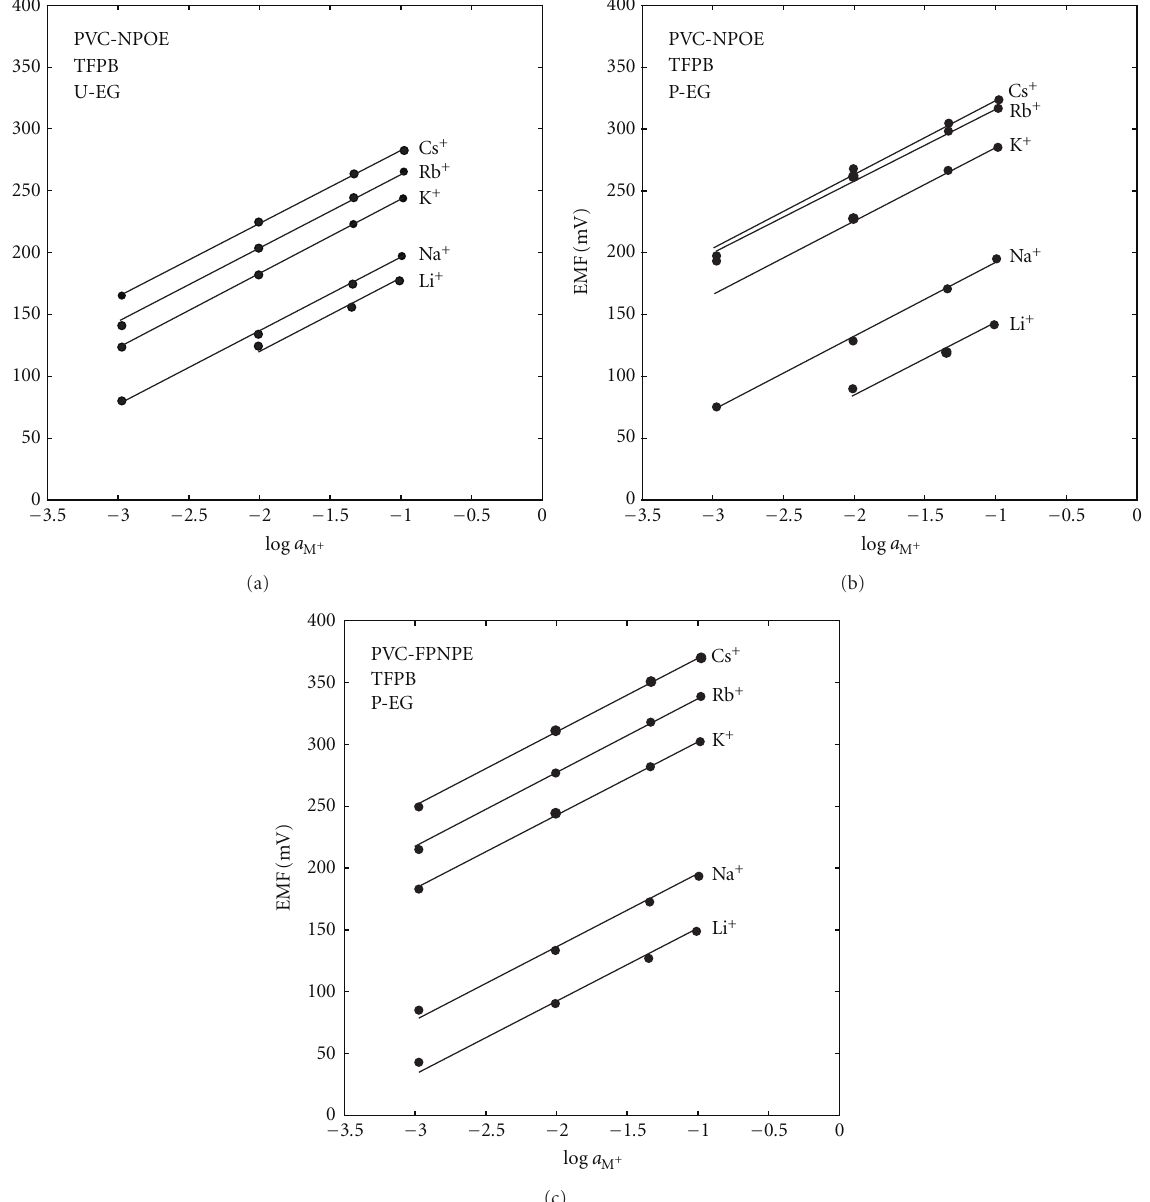
Figure 3: Mean potentiometric response towards alkali metal cations of PVC-NPOE membranes containing TFPB and either U-EG (a) or P-EG (b), or P-EG and TFPB plasticized with FPNPE (c). Solid lines denote a theoretical Nernstian